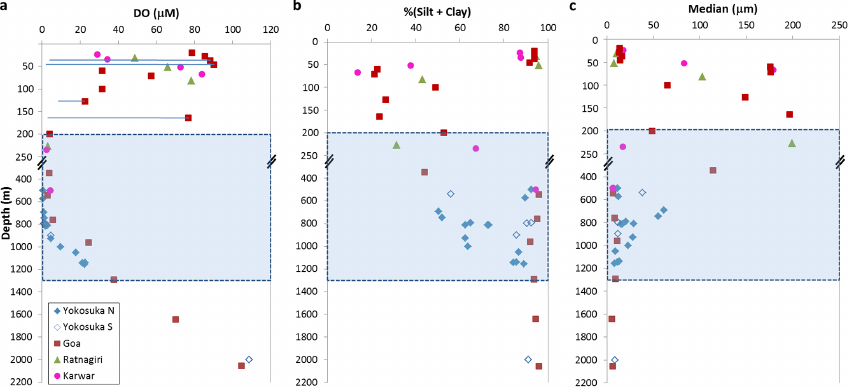
Figure 6. Plots against station depth (m) of (a) bottom-water dissolved oxygen concentration (DO, µM) at time of sampling, (b) percentage of silt and clay (by volume) in surficial sediments, and (c) median grain size (µm) in surficial sediments, from shelf and slope sites. DO concentrations were either measured directly from a submersible (Yokosuka transects) or in near-bottom bottle samples. All sediment samples and DO data for Goa, Ratnagiri and Karwar transect sites were collected during intermonsoon (normoxic) period. Horizontal lines for five Goa transect shelf sites indicate bottom-water DO values encountered during the late monsoon season (shelf